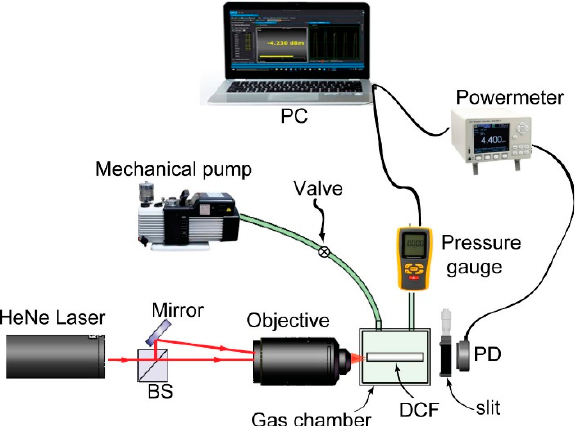
Figure 2. Schematic of the experimental setup of the gas refractometer. BS: beam splitter; PD: photodiode; DCF: dual-core fiber.